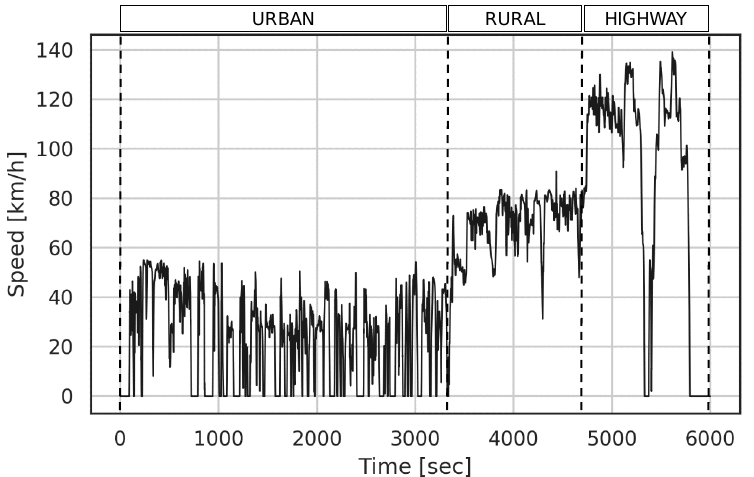
Figure 1. An example of a Real Driving Emission cycle divided into three main phases: urban, rural and highway paths.